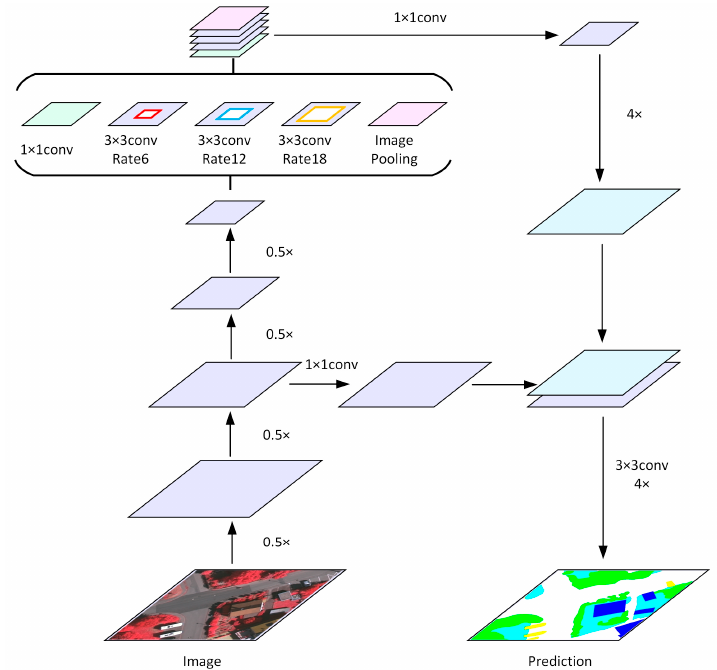
Figure 2. The DeepLabV3+ model architecture of 2D physical feature extraction.